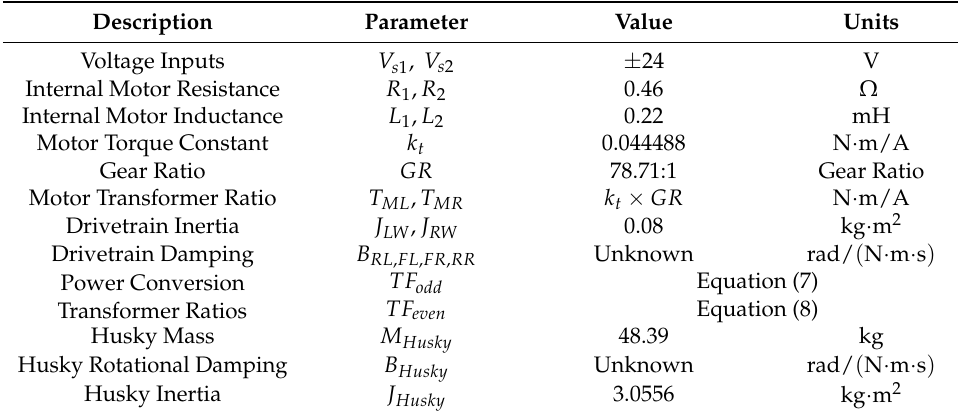
Table 1. State-space parameters, including unknown